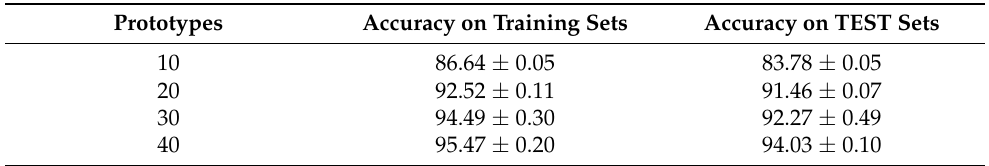
Table 3. The classification accuracy in percentage (mean ± standard deviation) under different numbers of prototypes on Pendigits dataset (30% as training